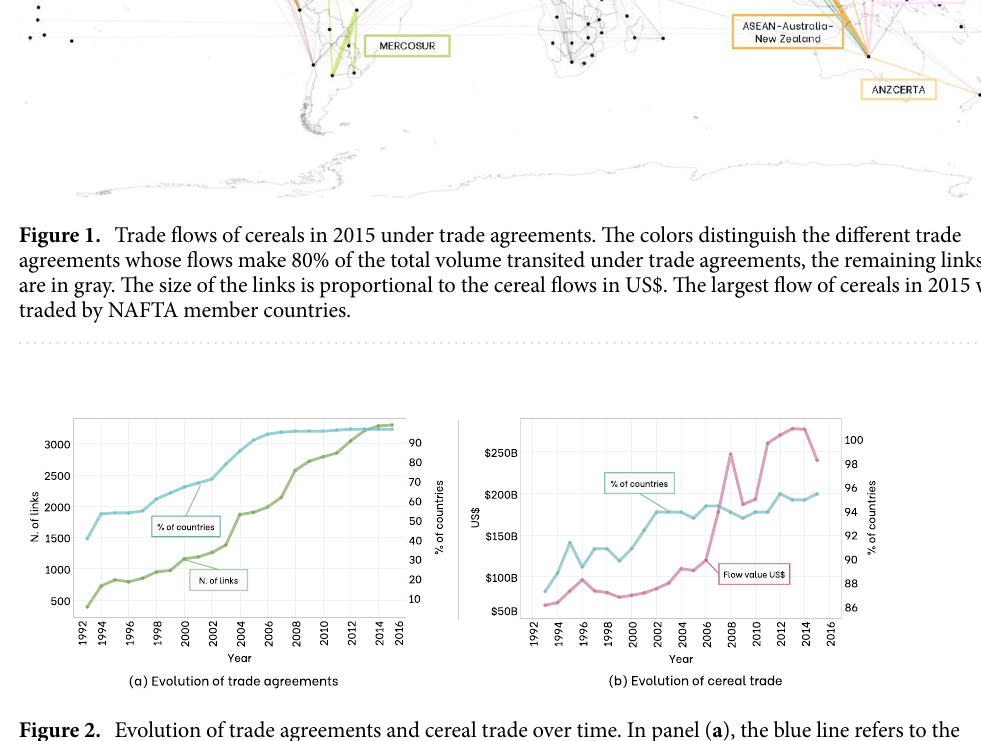
Figure 2. Evolution of trade agreements and cereal trade over time. In panel ( a ), the blue line refers to the percentage of countries covered by at least one trade agreement out of a total of 196, while the green line shows the number of links in the global cereal trade covered by agreements. In panel ( b ), the blue line refers to the percentage of countries involved in grain trade out of the total number (196) of countries according to FAOSTAT. In contrast, the magenta line reports the total grain flow in economic terms, billions of